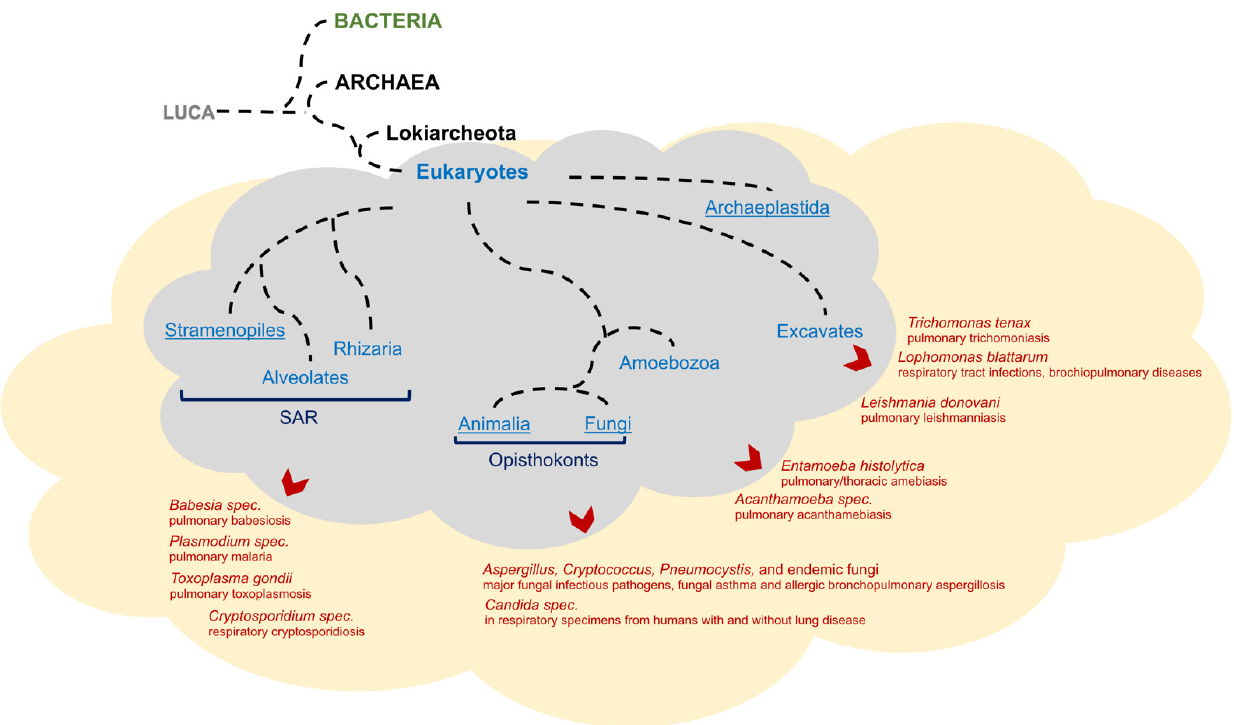
Figure 1. The domains of cellular life and hypothetical eukaryotic diversification. The tree of eukaryotes was adapted and simplified after Burki [18]. Pathogens from diverse eukaryotic clades contribute to human respiratory tract microbiomes and can be causally related to several diseases, e.g., apicomplexa to pulmonary babesiasis/malaria/toxoplasmosis/leishmanniasis [19] or respiratory cryptosporidiosis [20]. Multiple fungal species are associated with respiratory diseases, e.g., asthma [21], or occur in the respiratory tract [22,23]. Amoebozoa can be associated with thoracic amebiasis [24] or acanthamebiasis [19] or can be opportunistic free-living [25]. Excavates, such as Lophomonas blattarum , can cause respiratory tract infections and bronchopulmonary disease [26,27]. Moreover, pulmonary trichomoniasis can be related to trichomonad excavates [28]. Abbreviation: Last Universal Common Ancestor (LUCA). In underlined eukaryotic clades, multicellularity occurs, whereby Animalia exclusively contain multicellular